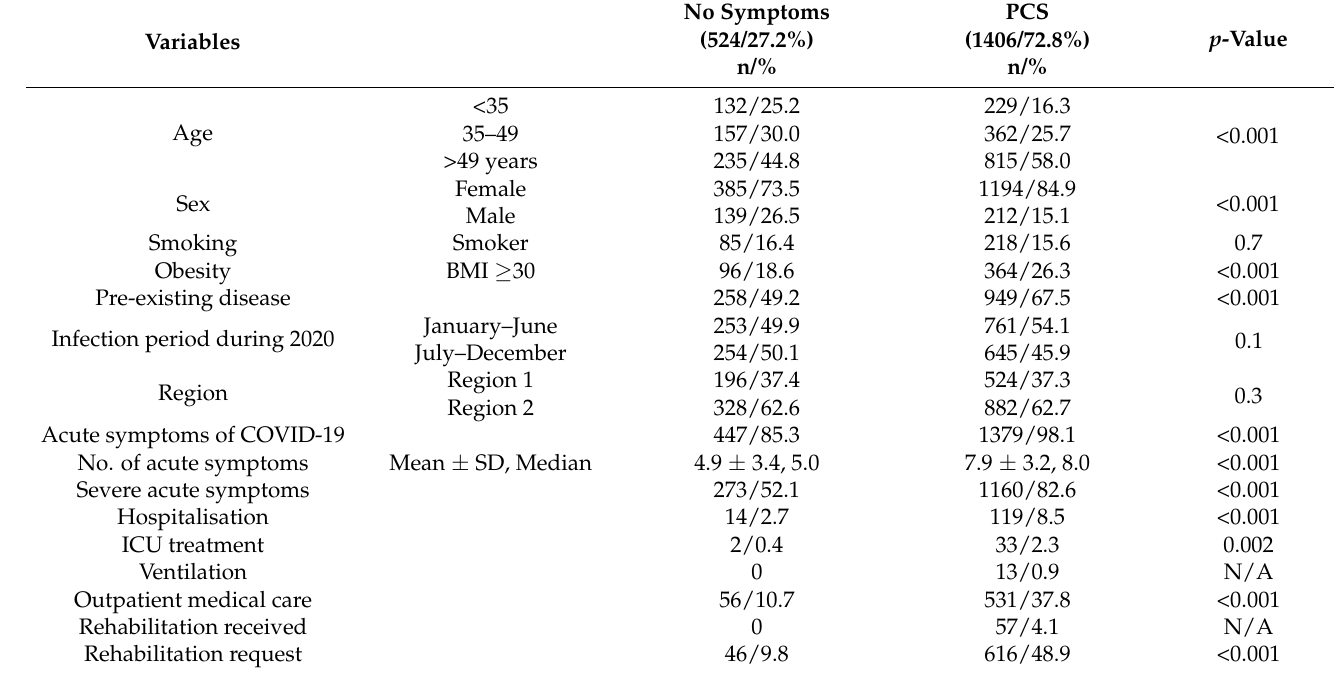
Table 2. Characteristics of participants with symptoms persisting more than 3 months (PCS) vs. no symptoms (n =